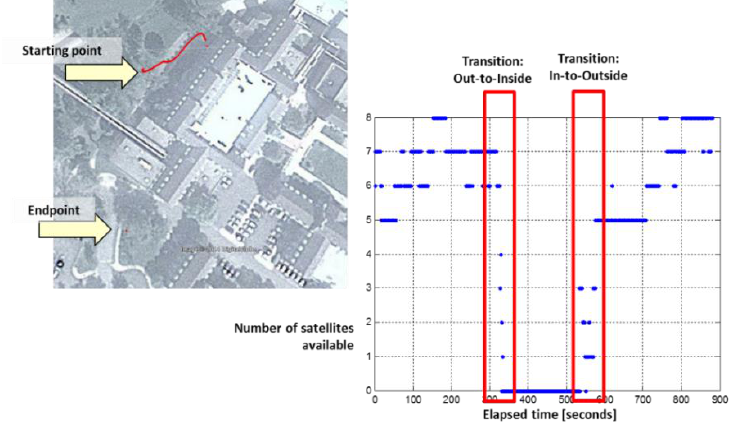
Figure 9. Filtered GPS